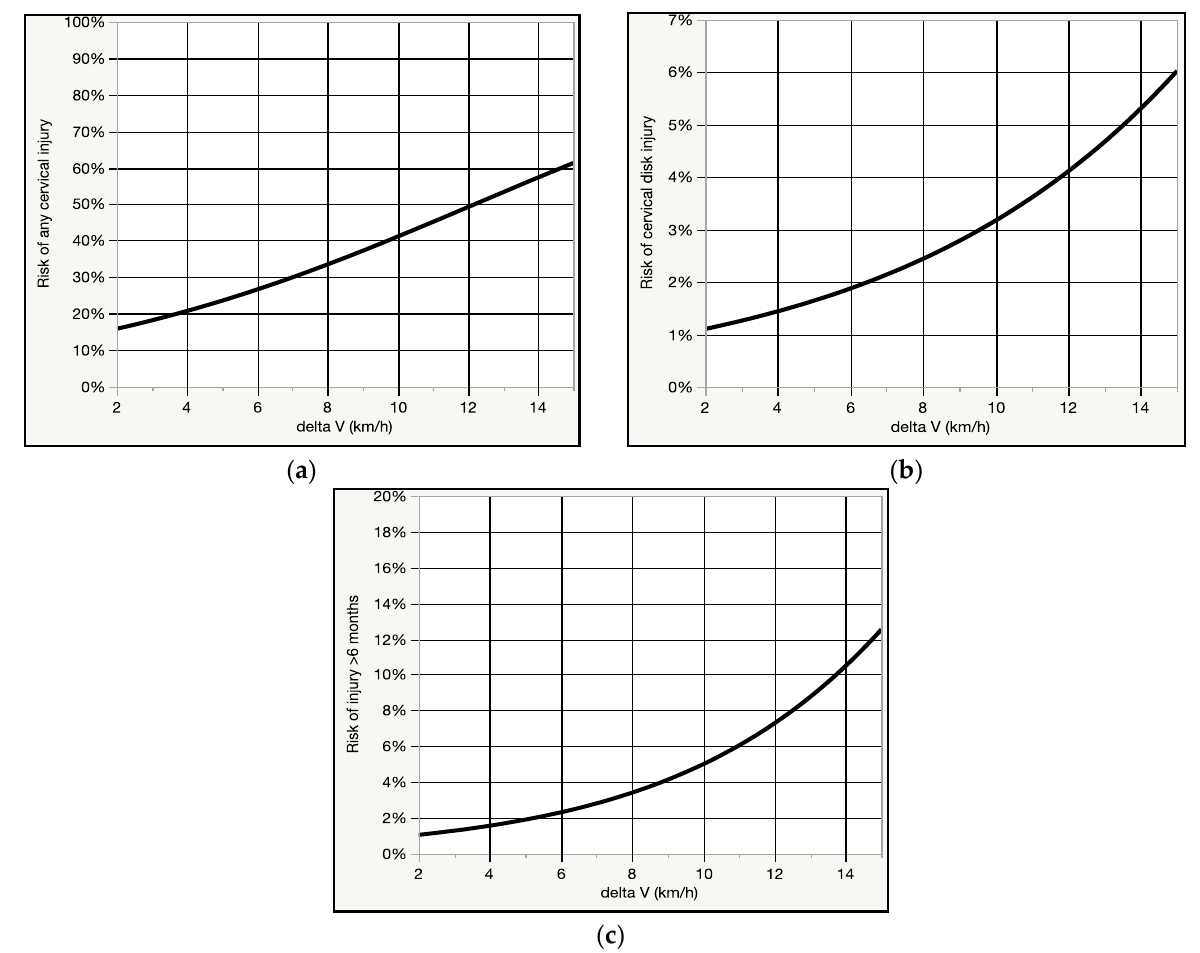
Figure 6. ( a ) Binomial fit of risk of any cervical spine injury vs. delta V (km/h) for 113 patients. ( b ) Binomial fit of risk of cervical disk/radiculopathy diagnosis vs. delta V (km/h) for 113 patients. ( c ) Binomial fit of risk of cervical spine injury lasting >6 months vs. delta V (km/h) for 114 patients.